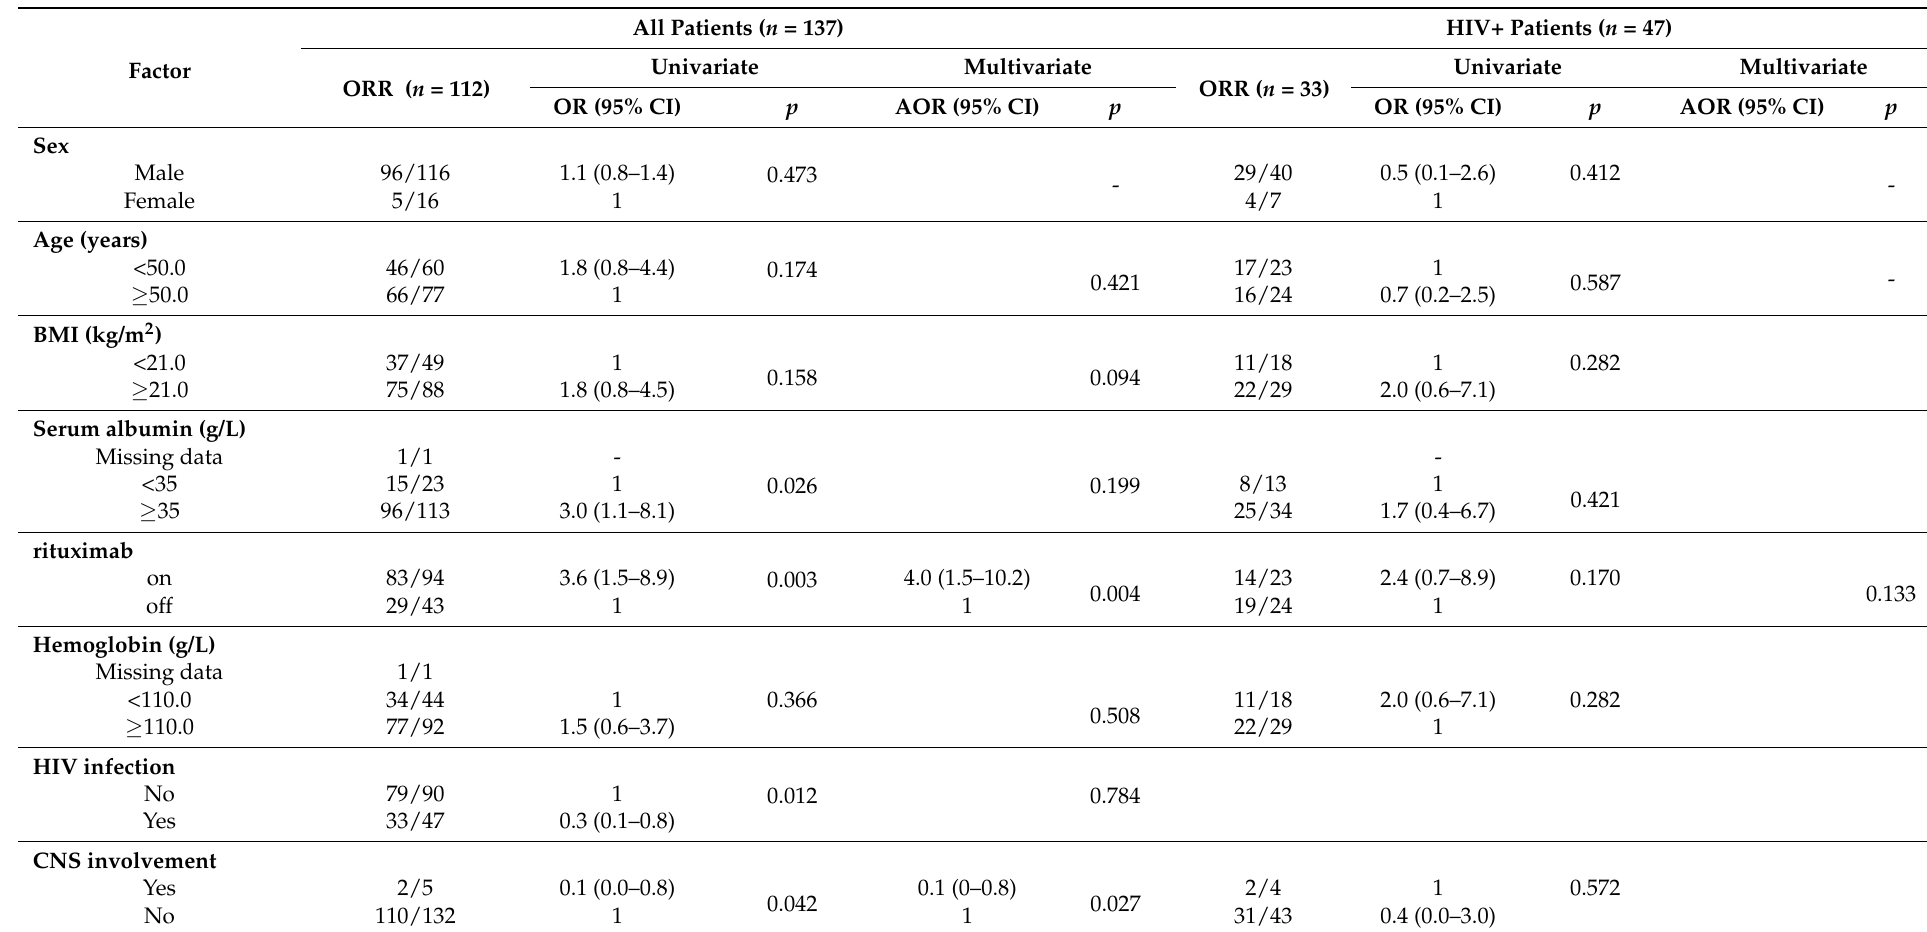
Table 3. Risk factors for overall response rate in DLBCL patients who accepted